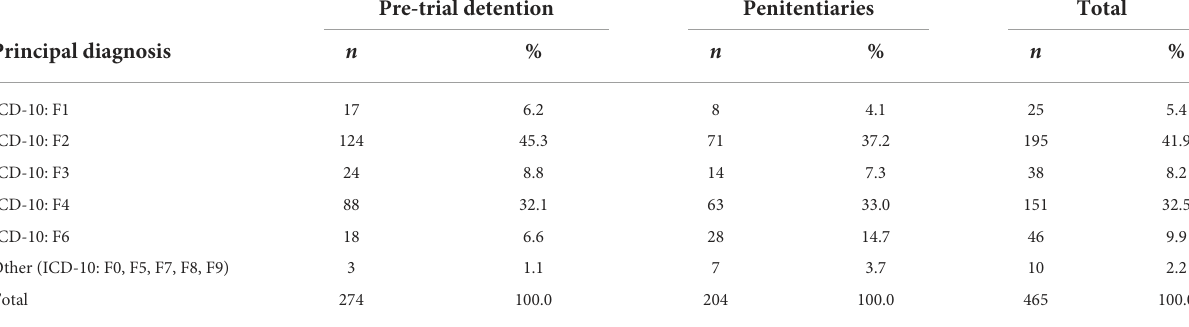
TABLE 4 Comparison of principal diagnoses in individuals admitted to psychiatric hospitals for crisis intervention between 2014 and 2018 by type of correctional setting ( N = 465). Pre-trial detention Penitentiaries Total